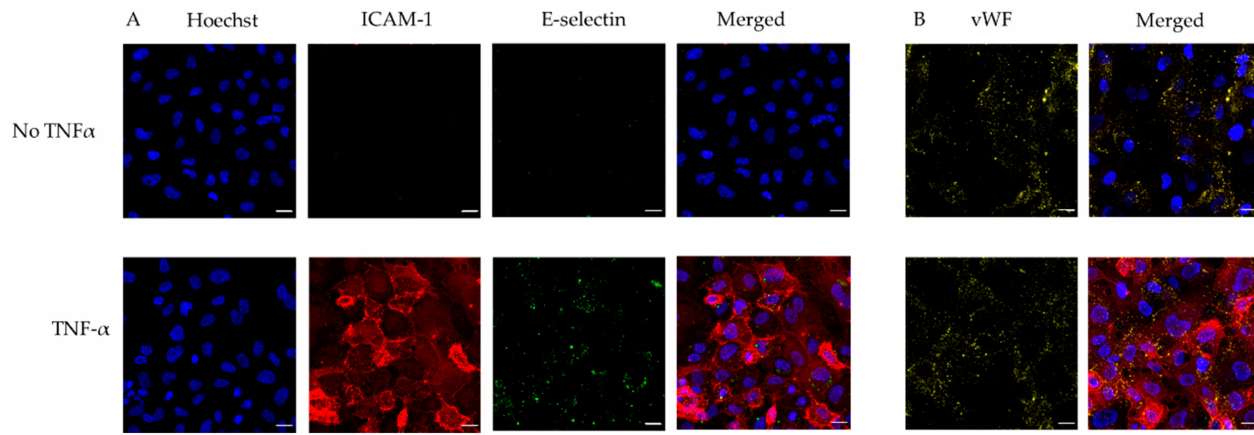
Figure 3. Expression of surface adhesion proteins on human umbilical vein endothelial cells (HUVECs) in the endothelialised chips. ( A ) Confocal micrographs showing maximum intensity projections of z-stacks stained for nuclei (blue), intercellular adhesion molecule 1 (ICAM-1) (red), E-selectin (green) and ( B ) von Willebrand factor (vWF) (yellow) of non-treated (no tumour necrosis factor alpha (“No TNF- α ”) and TNF- α treated (“TNF- α ”) HUVECs-on chip. Scale bars represent 20 µ